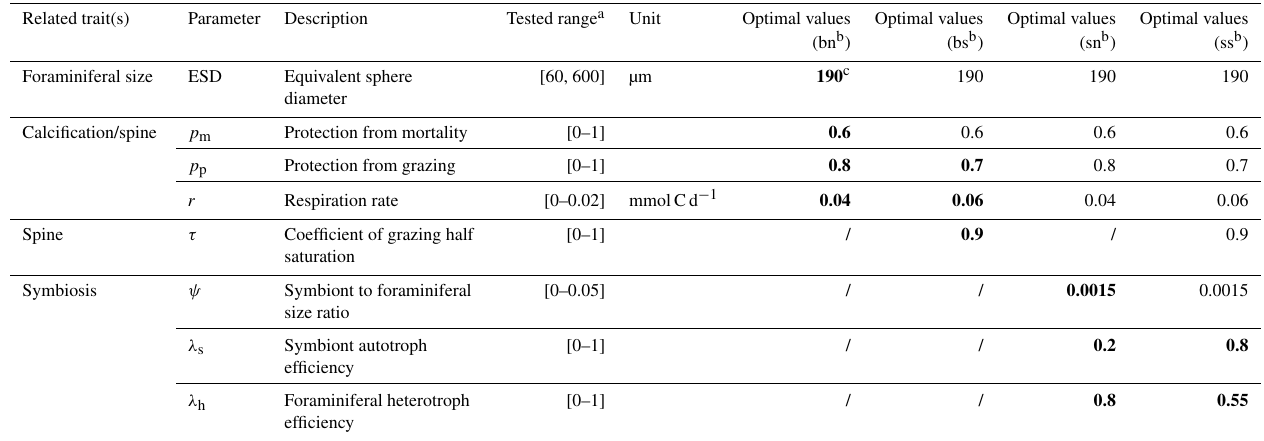
Table 2. List of the foraminifera-relevant model parameters tested in the global sensitivity analysis (GSA) and identified optimal parameter values for each foraminiferal